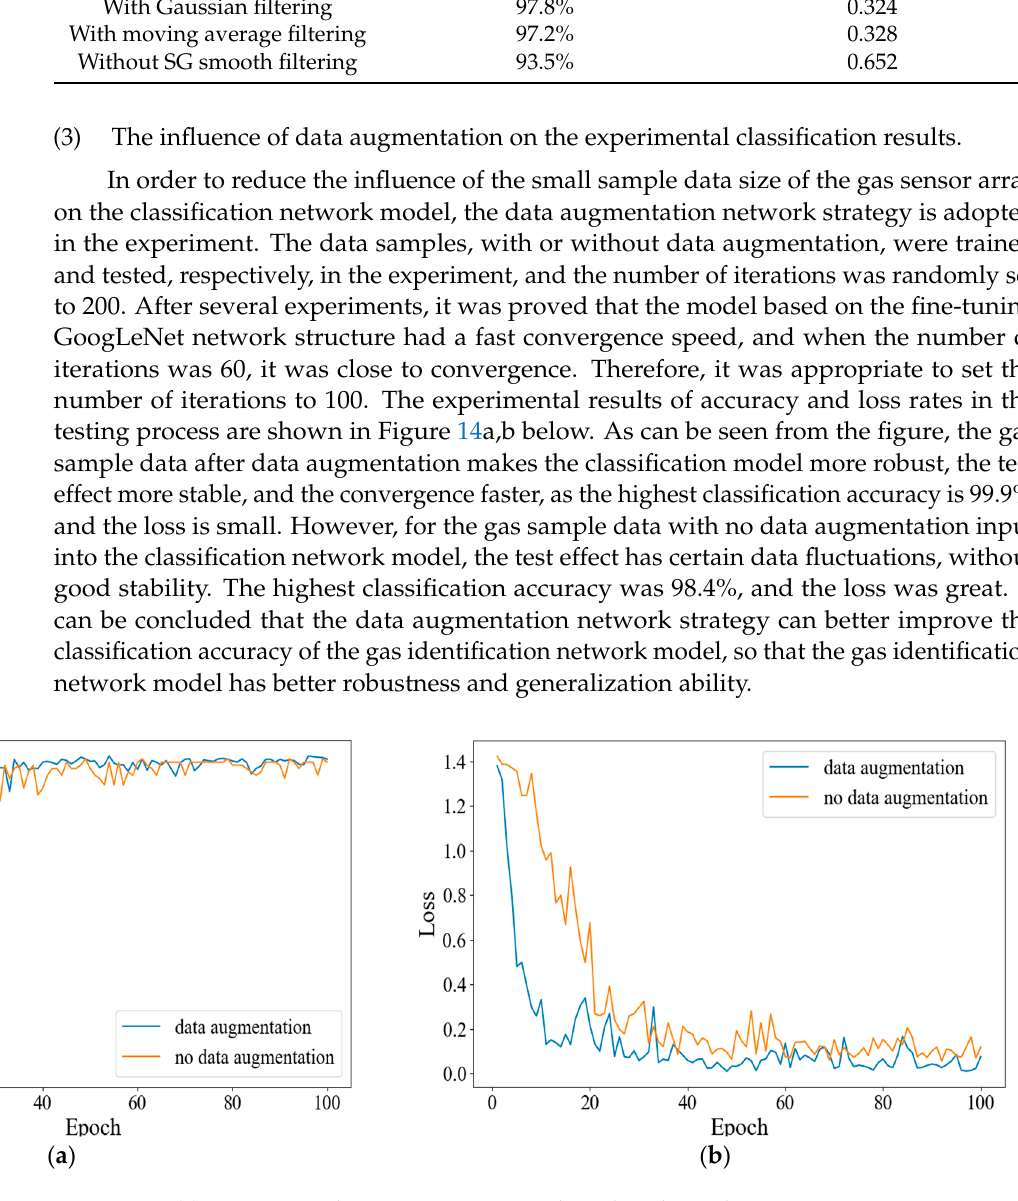
Table 6. Data partition